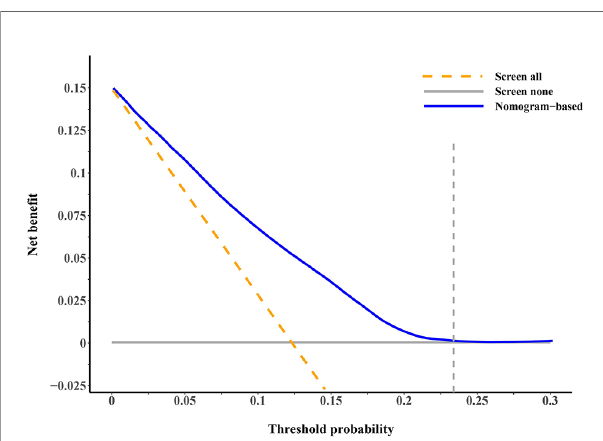
FIGURE 4 | Decision curve analysis for evaluating the clinical utility of our proposed competing-risk nomogram. The x -axis is the threshold probability for screening of second primary malignancies (SPMs) and the y -axis is the corresponding net bene fi t. The blue solid line depicts the net bene fi ts change of screening using our proposed nomogram under different threshold probabilities, whereas the gold dashed line and gray solid line represent the net bene fi t of screening all and screening no patients. As the decision curve noted, using the nomogram as the screening tool when the threshold probability was between 1% and 23% would obtain more clinical bene fi ts than simply screening all patients or screening no